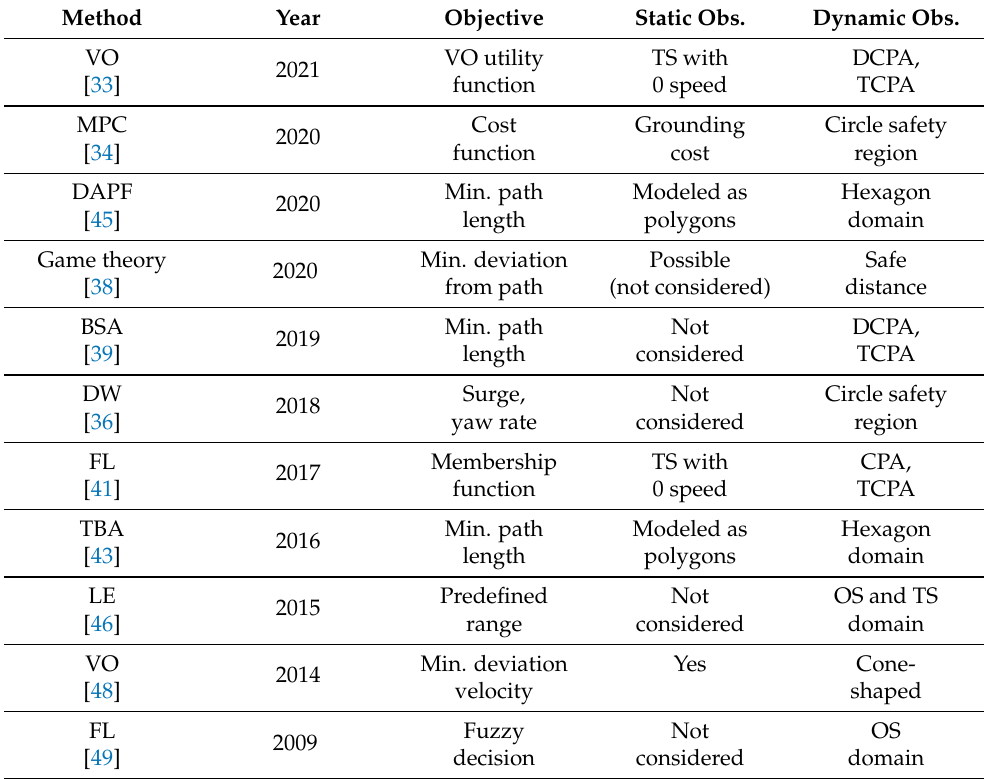
Table 3. A comparison of deterministic methods applying radar remote sensing and other sensors— part